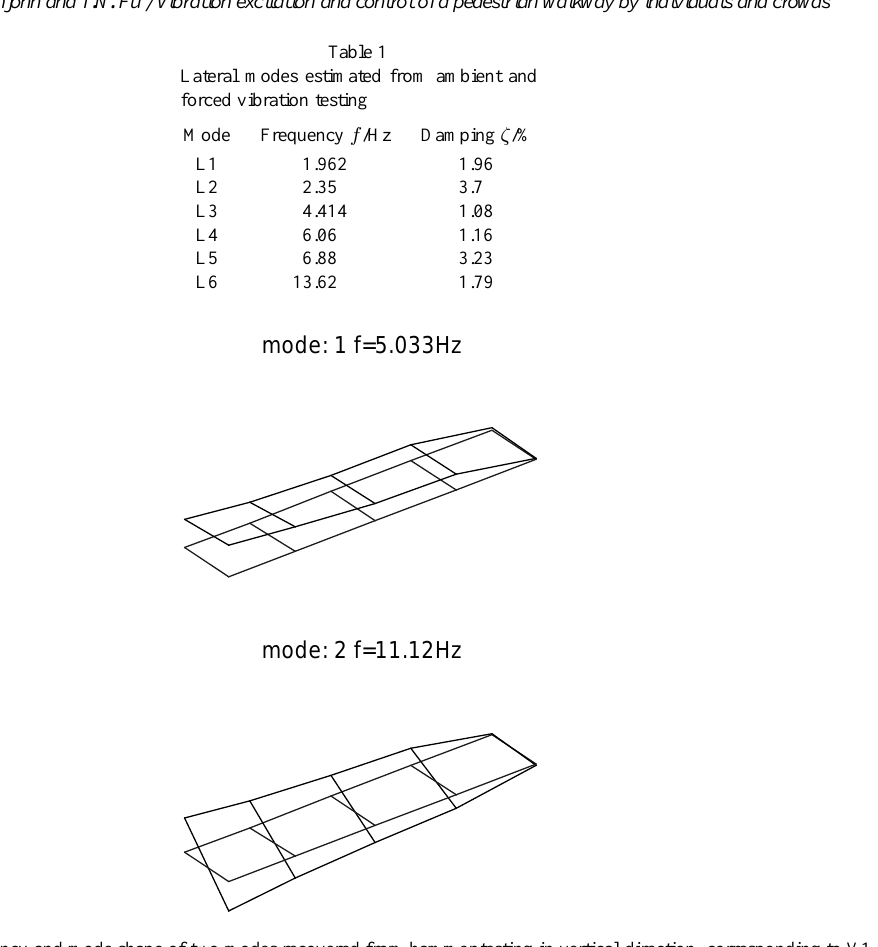
Fig. 4. Estimates of frequency and mode shape of two modes recovered from hammer testing in vertical direction, corresponding to V1 and